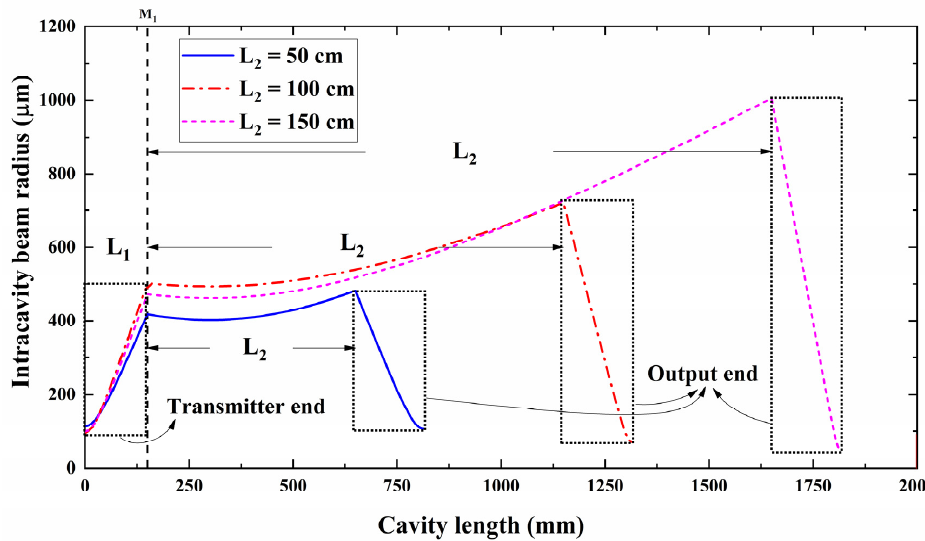
Figure 5. VECSEL internal oscillating laser beam distribution for L 4 values of 50, 100, and 150 cm.